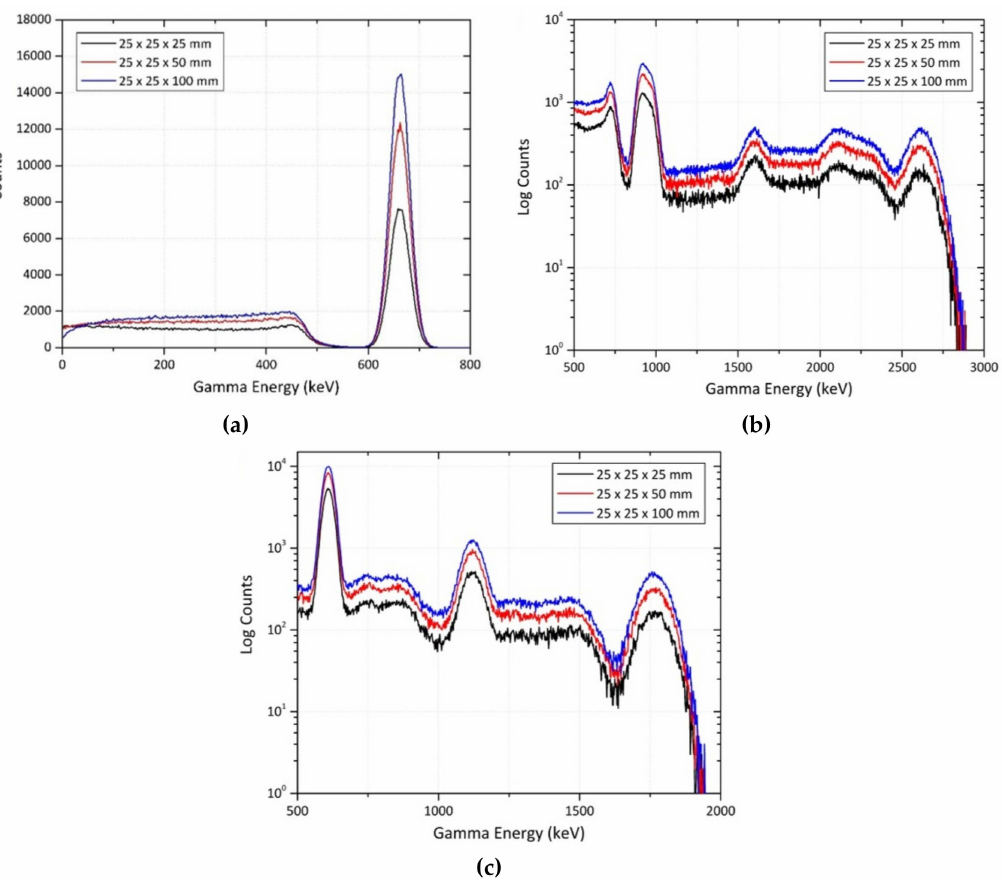
Figure 2. GEANT4 simulated CsI(Na) detector response for varying thicknesses when exposed to;